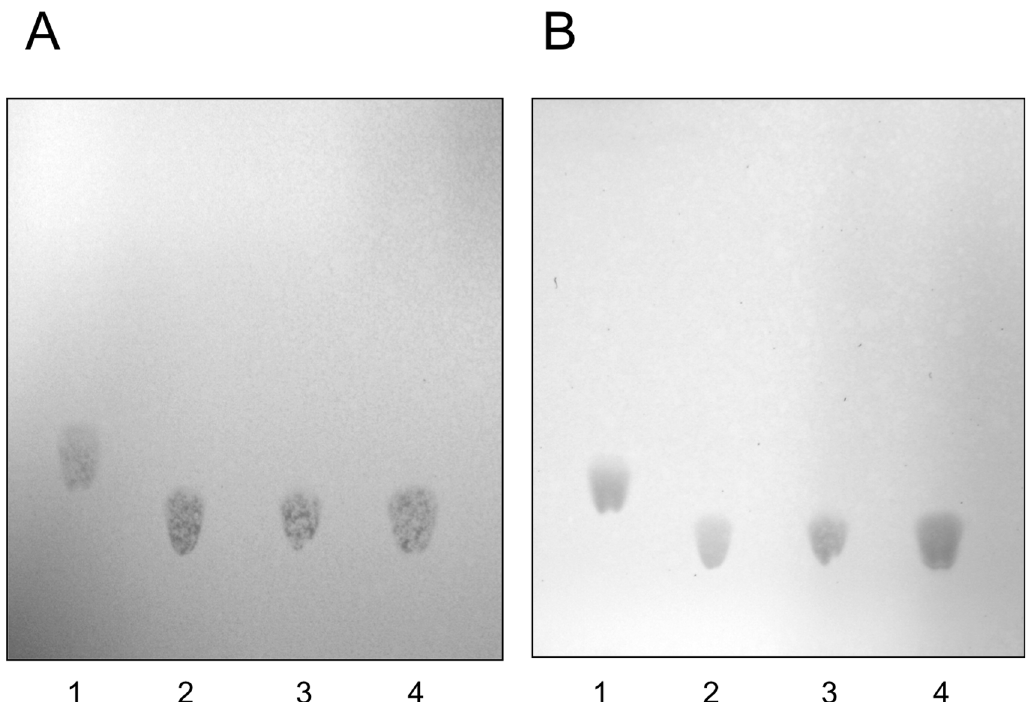
Fig 3. Thin-layer chromatogram of the F7 lipid fraction. The F7 lipid fraction was analyzed with Dittmer reagent (A) or 50% sulfuric acid (B) with a chloroform – methanol – water mixture (65:35:8, v/v/v). 1, Sphingomyelin; 2, Lyso-PAF; 3, F7 lipid fraction; 4,